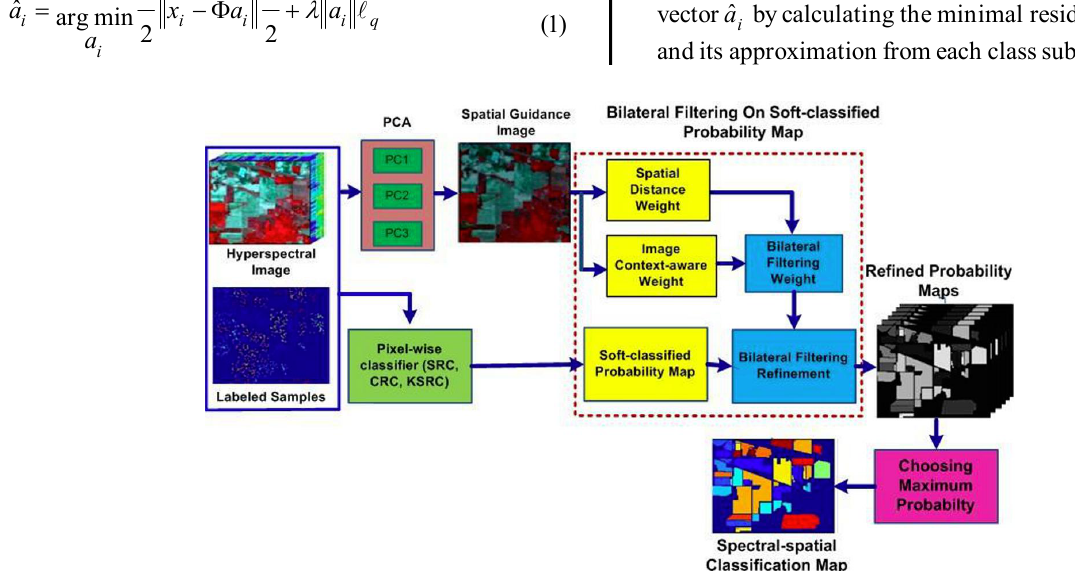
FIG. 1. TWO STAGE FRAMEWORK COMBINING PIXEL-WISE CLASSIFIER WITH